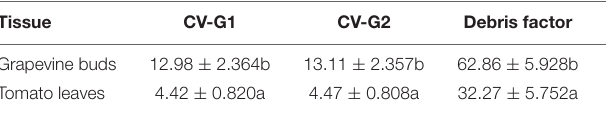
TABLE 1 | Assessment of the quality of nuclei suspension prepared from grapevine buds and young tomato